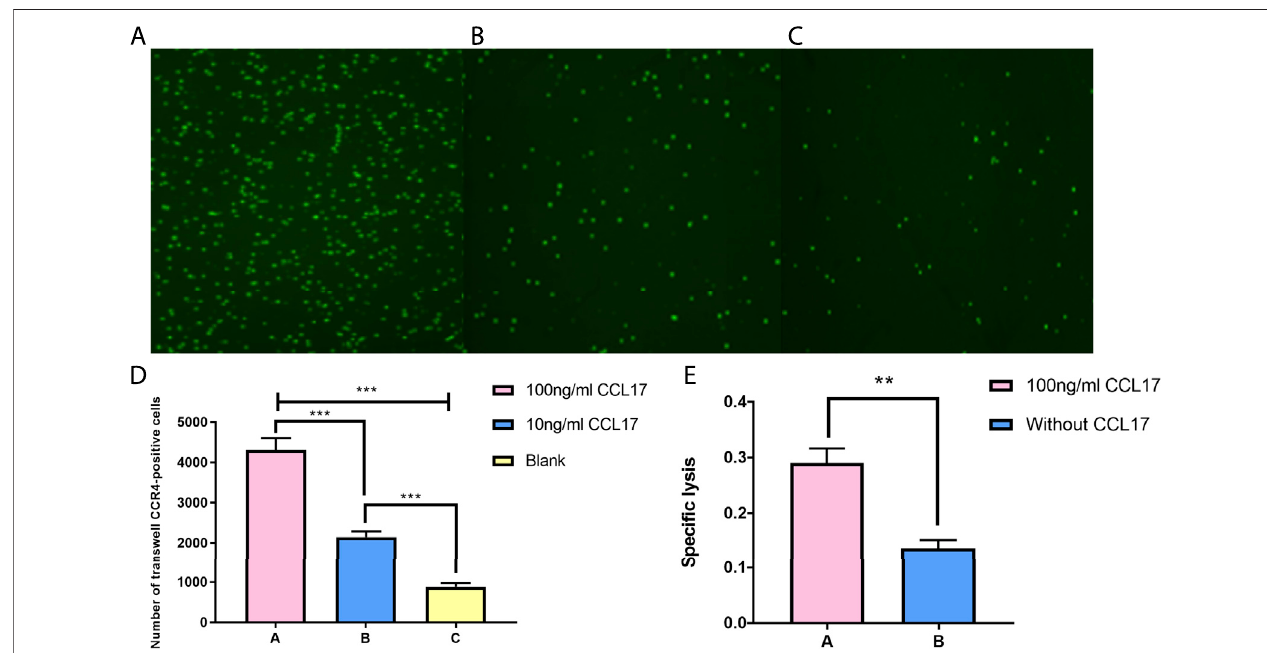
FIGURE 15 | (A-C) CFSE staining of CCR4-positive lymphocytes in the lower chamber under different concentrations of CCL17 chemotaxis. (A) 100 ng/ml CCL17, (B) 10 ng/ml CCL17, and (C) blank. (D) Number of CCR4-positive lymphocytes chemotactic to the lower chamber at different concentrations of CCL17 (*** p < 0.001). (E) Speci fi c lysis of CCR4-positive lymphocytes in the lower chamber on LUAD H1993 cells (* p <